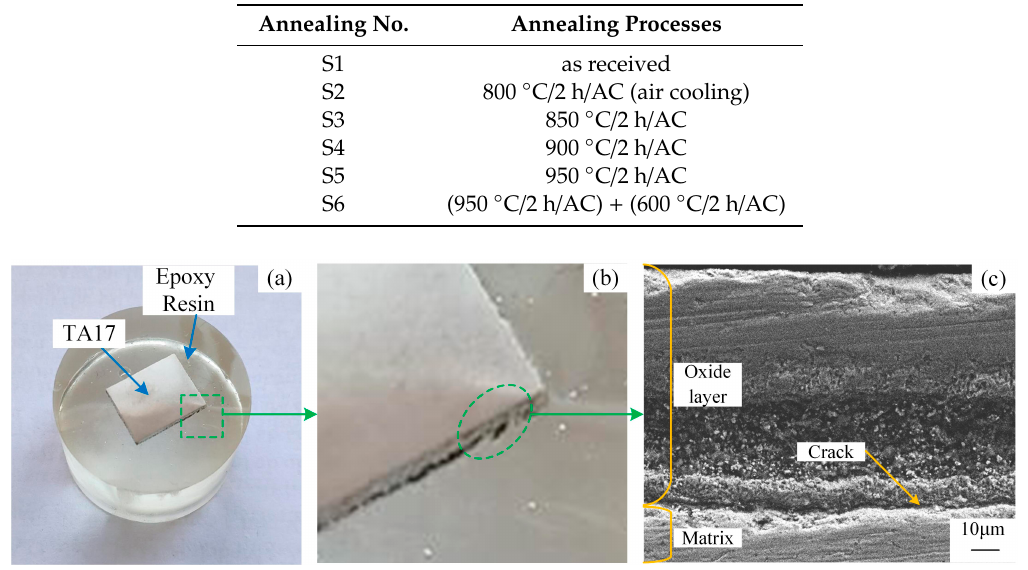
Figure 1. ( a ) Specimen for scanning electron microscope (SEM); ( b ) The partial enlarged view; ( c ) The microstructure of TA17 after 800 °C oxidation.